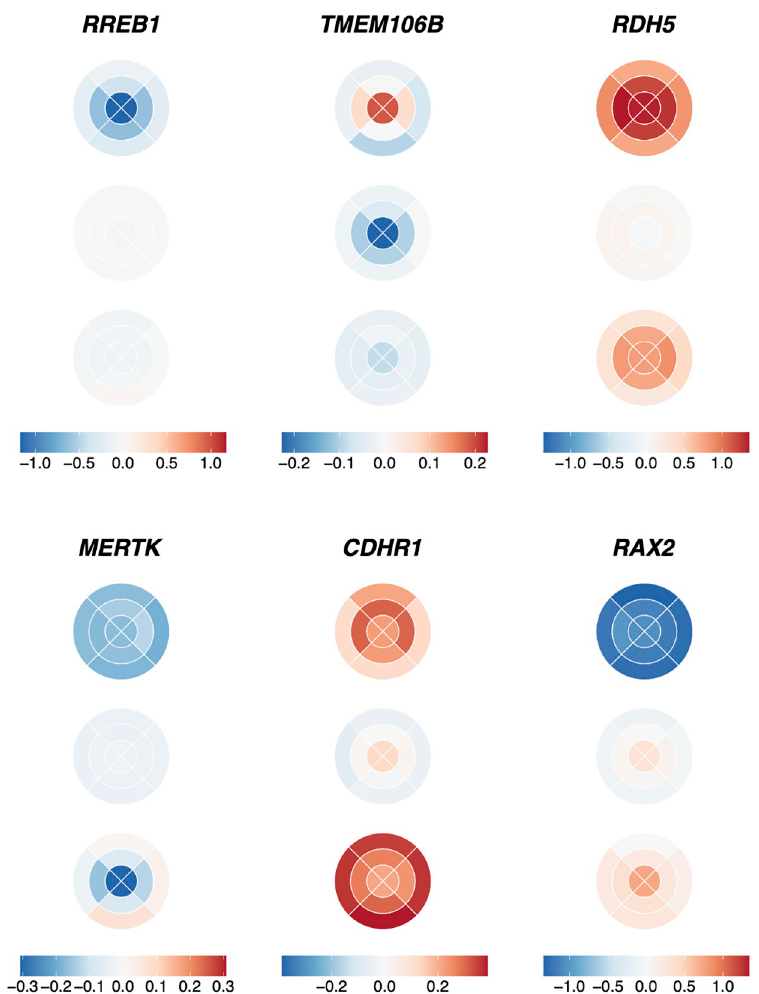
Fig 7. Effect size of selected SNPs on ETDRS grid. The figure shows the effect size of the SNPs (shown by a blue-red gradient) with differential effect on the concentric fields of the retina, on the nine different segments of the ETDRS grid across the three PRC layers listed from top to bottom: ONL, IS and OS. Six loci are visualised: RREB1 (rs75757892), TMEM106B (rs13237518), RDH5 (rs3138142), MERTK (rs869016), CDHR1 (rs55798570), and RAX2 (rs76076446). Effect sizes are scaled for each genetic locus